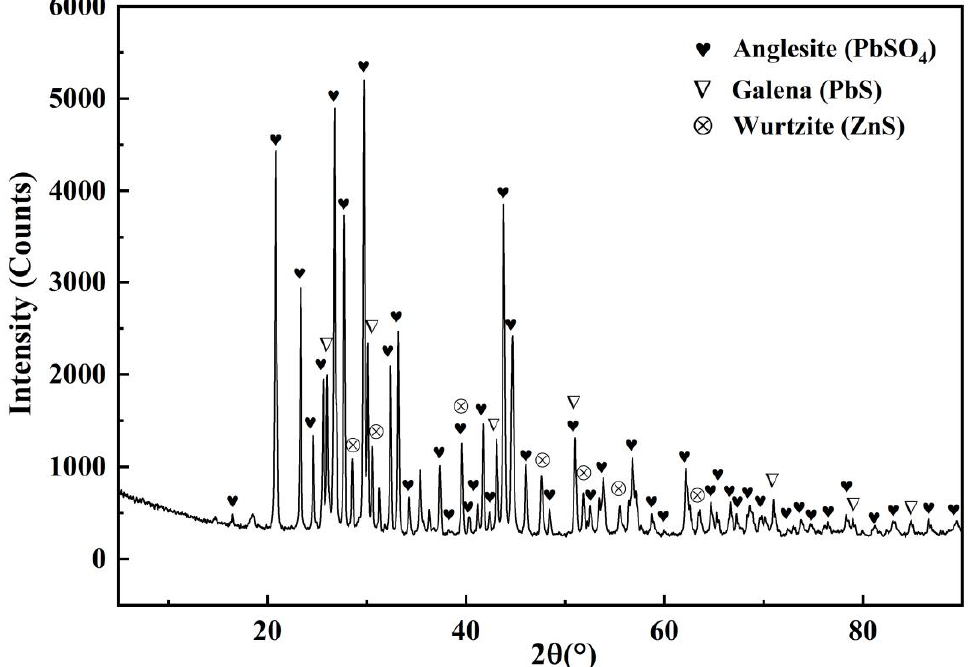
Figure 10. XRD pattern of atmospheric leaching residue (initial acidity = 160 g·L − 1 , leaching temper- ature = 90 °C, leaching time = 60 min, and L/S mass ratio = 5:1). Figure 11 is a SEM image of the leaching residue. The EDS analysis results of the five points selected in Figure 11 for the leaching residue are shown in Table 5. The structure and shape of the leaching residue are mainly composed of five shapes: sphere, acicular, block, tetragonal and flocculent (marked with numbers 1 – 5). According to the analysis results in Figure 11, the following conclusions can be drawn: spot 1 is a spherical structure, the main phase of which is ZnS, and contains trace PbS, PbSO 4 and SiO 2 . Spot 2 is a needle structure, the main phase of which is PbSO 4 , and contains trace ZnS, PbS, SiO 2 and Fe oxides. Spot 3 is a block structure, the main phase is PbSO 4 , and contains a small amount of ZnS and PbS; the tetragonal structure of the monomer at spot 4 is mainly composed of PbSO 4 particles and contains trace PbS and ZnS; and the flocculent structure of the mon- omer at spot 5 is mainly composed of PbSO 4 and contains trace PbS and ZnS.